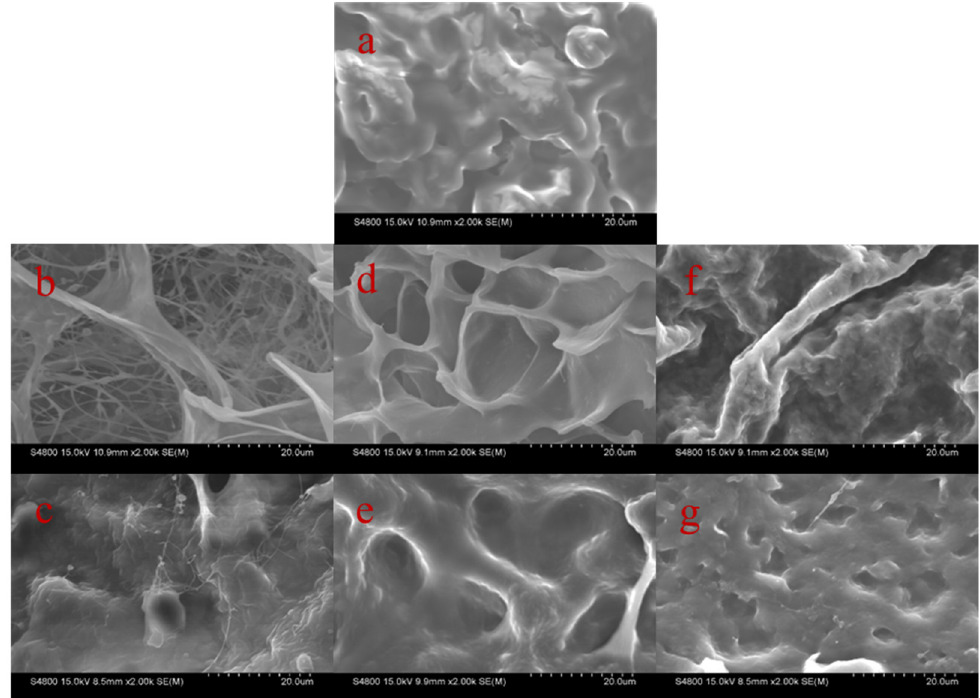
Figure 3. SEM of RBOB-FG emulsion-filled gel samples: RBOB emulsion ( a ), FG hydrogel (0.2 % FG) ( b ), RBOB-FG emulsion-filled gel (0.2 % FG) ( c ), FG hydrogel (0.8 % FG) ( d ), RBOB-FG emulsion-filled gel (0.8 % FG) ( e ), FG hydrogel (2.0 % FG) ( f ), and RBOB-FG emulsion-filled gel (2.0 % FG) ( g ).